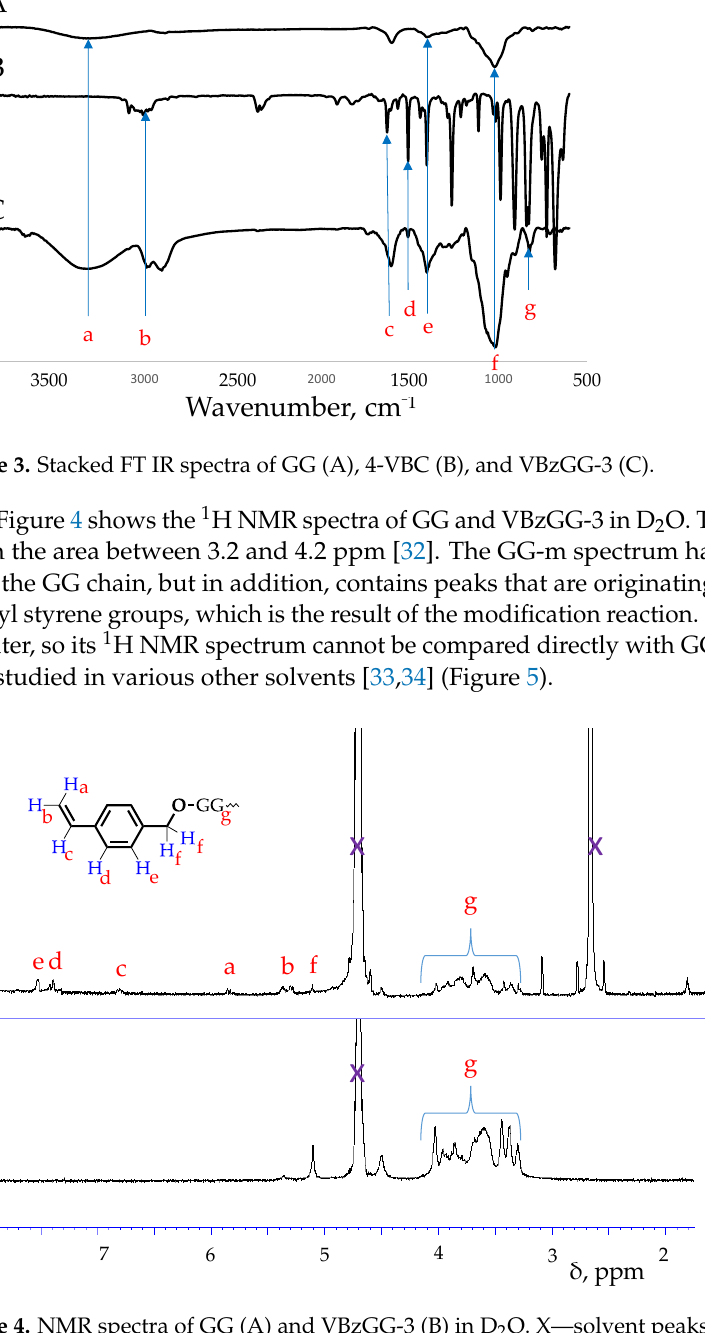
Figure 5. NMR spectrum of 4-VBC in deuterated chloroform. X — solvent peak. 2.2. Preparation and Characterization of GG-m/PSt Gels VBzGG-m/St bulk radical copolymerization was initiated by 2, 2′ -azobis(isobutyroni- trile), AIBN (Scheme 2). There are several products that could be formed during this pro- cess: PSt homopolymer (Scheme 2A), bottle brush-like copolymer (VBzGG-m- graft -PSt, Scheme 2B), semi-interpenetrating network (PSt-VBzGG SIPN, Scheme 2C), and conet- work (PSt- l -VBzGG-m, Scheme 2D). The possibility for VBzGG-m homopolymerization is statistically very low due to the small content of the macromonomer in the copolymeriza- tion mixture.